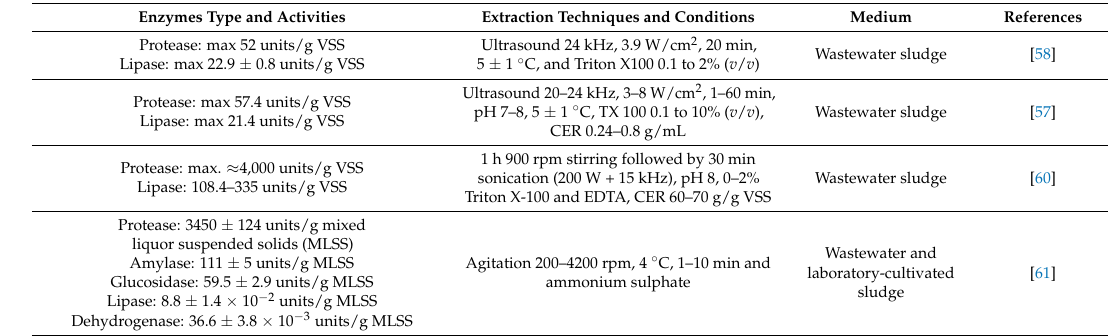
Enzymes Type and Activities Extraction Techniques and